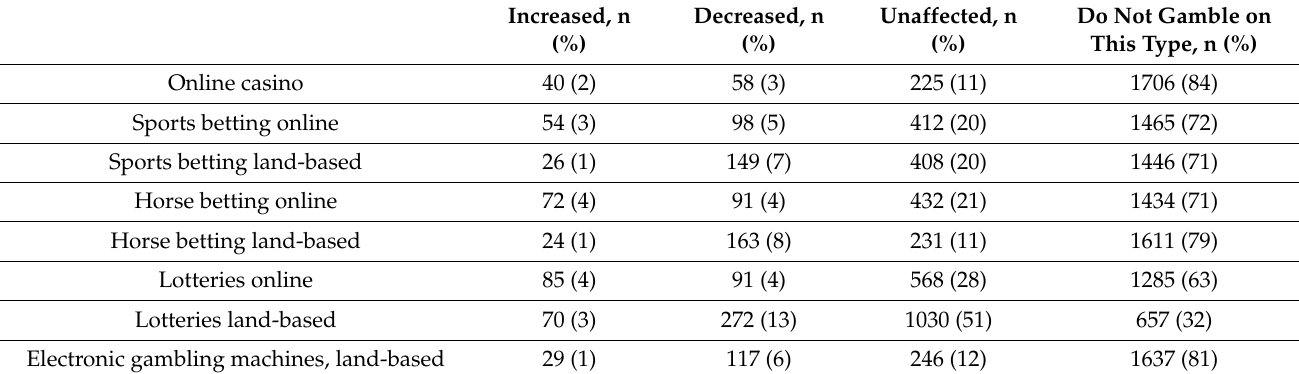
Table 2. Self-reported COVID-19 effect on each type of gambling. All items including 2029 subjects.